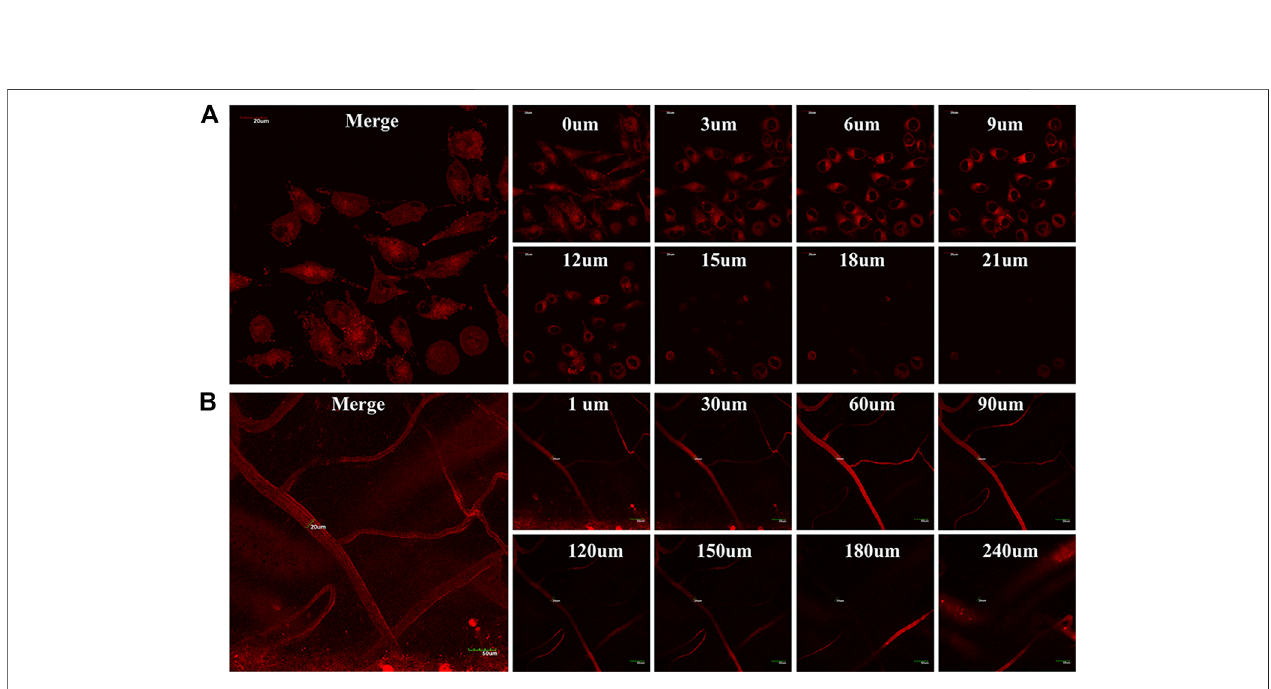
FIGURE 4 | (A) TP fl uorescent imaging of TTRE in living cells (B) TP fl uorescent imaging of vascular in liver.